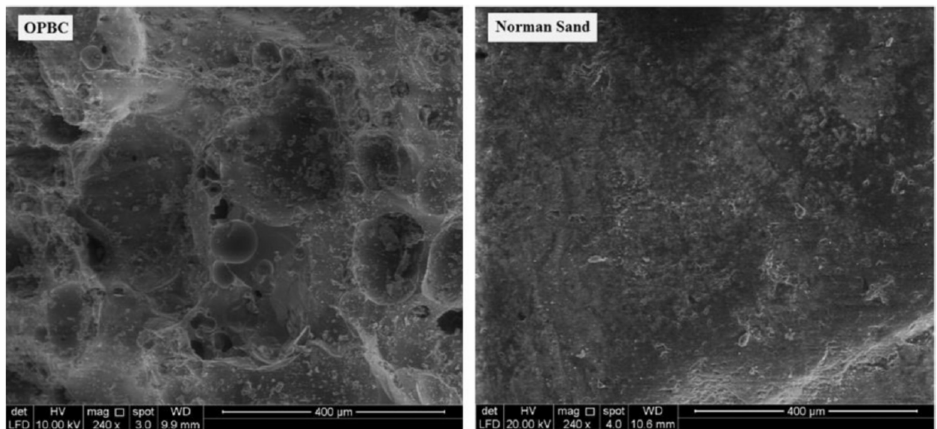
Figure 5. Scanning electron microscopy image for the surface texture of oil-palm-boiler clinker (OPBC) and normal sand [50], with copyright permission from